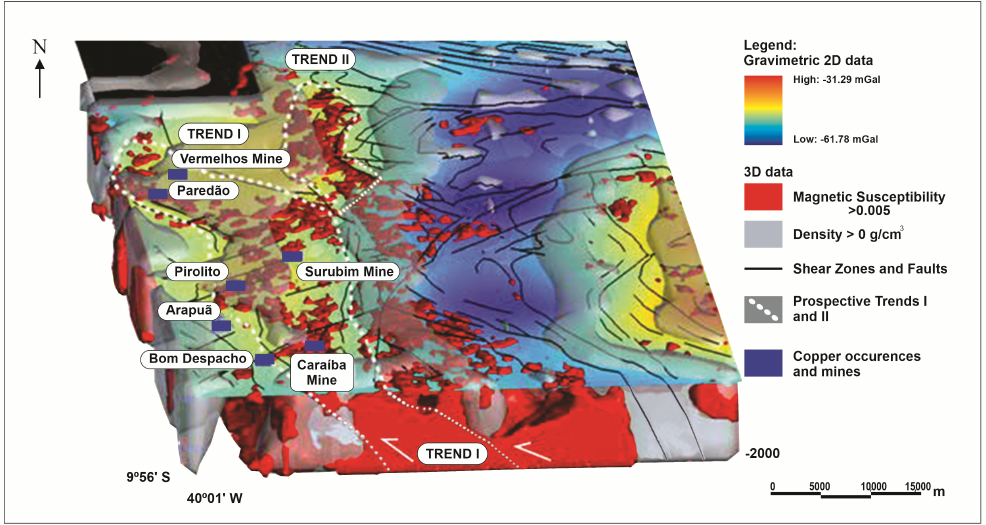
Figure 12. The IOCG mineral system in the region of the Vale do Curaç á Copper District, in regional terms, shows two main prospective trends. The trends are positioned in the contact zone between domains with high magnetic susceptibility ( > 0.005 SI) and density ( > 0 g / cm 3 ) and show contrasts in density and magnetite